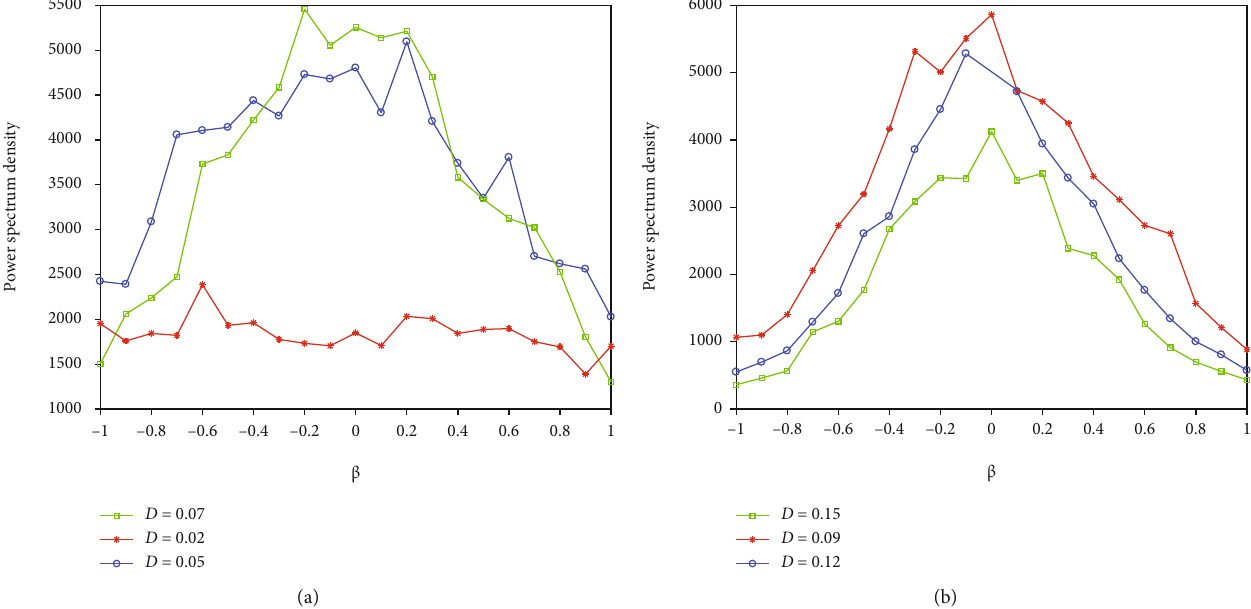
Figure 7: The relationship between symmetric parameter β and system output of undamped bistable system driven by Lévy noise. (a) The output when input white noise intensity is D = 0 : 02 , 0.05, and 0.07. (b) The output when input white noise intensity is D = 0 : 09 , 0.12, and